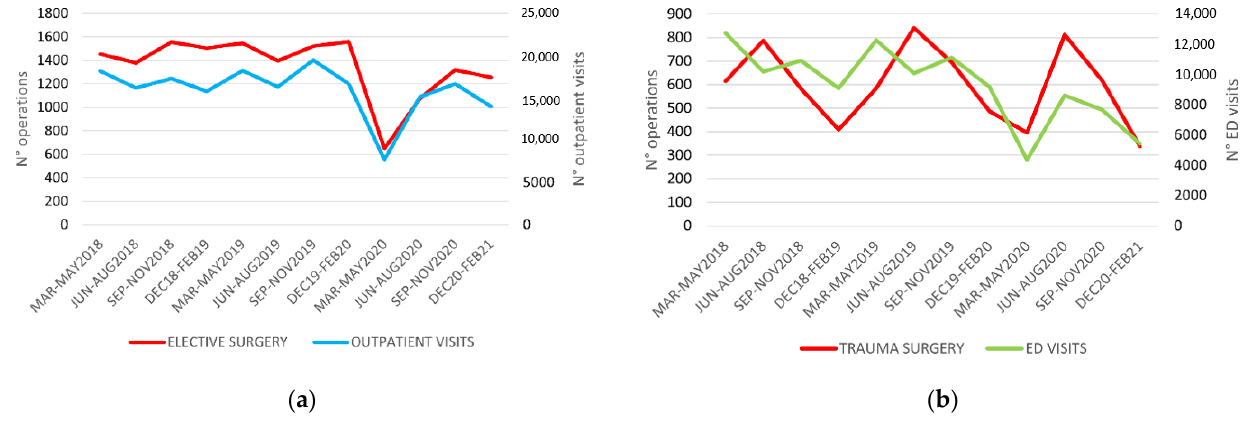
Figure 3. Trend of elective surgery during the period March 2018–February 2021: ( a ) in relationship with the outpatient visits; ( b ) in relationship with the Emergency Department (ED) visits.